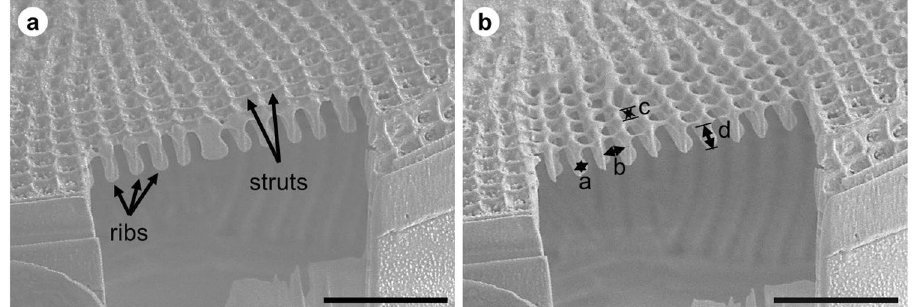
Figure 6. ( a ) SEM images of an FIB cross-section of the D. geminata frustule showing internal ribs. ( b ) The cross-section after further cuts with marked dimensions. Scale bars: 5 µ m.